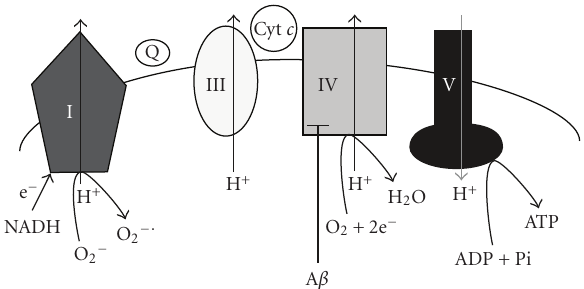
Figure 1: The relationship between amyloid- β (A β ), mitochondrial electron transport chain (ETC), and superoxide (O −• 2 ) formation. As electrons are transferred through complexes I, III, and IV, protons are pumped into the inner membrane space, generating an electrochemical gradient. The energy stored is used to generate ATP via complex V (ATP synthase). Damage to components